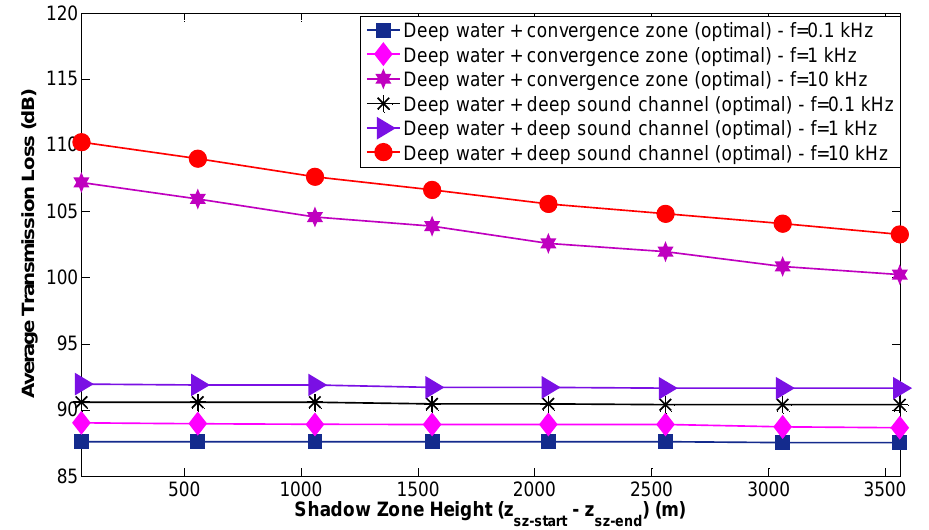
Figure 17. Average transmission loss of a link as a function of the shadow zone height in deep